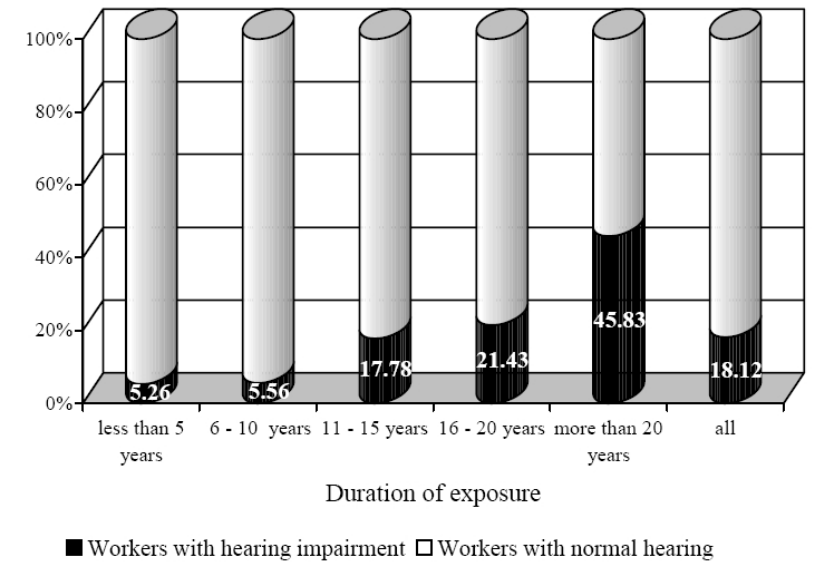
Fig. 1 Rates of cases of hearing impairment in workers exposed to excessive noise de- pending on the duration of